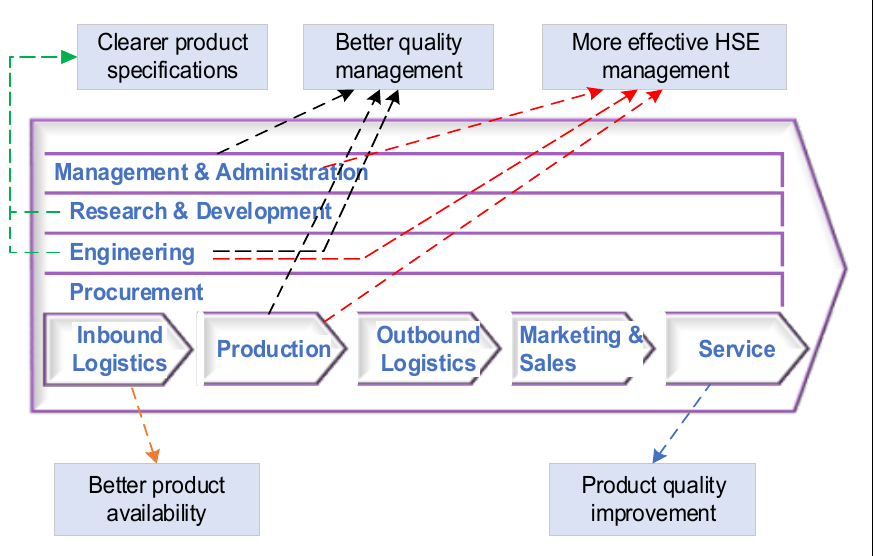
Figure 8. Impacts of SB standard on battery manufacturer’s business functions.